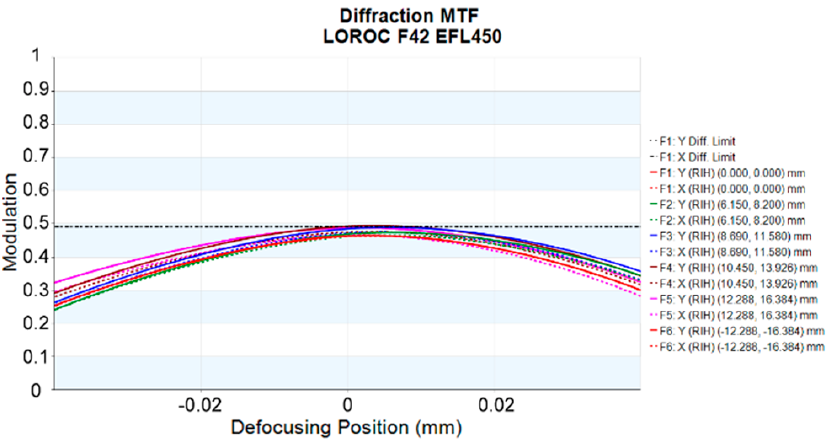
Figure 6. MTF-defocus amount curves of the optical system (80 lp/mm).